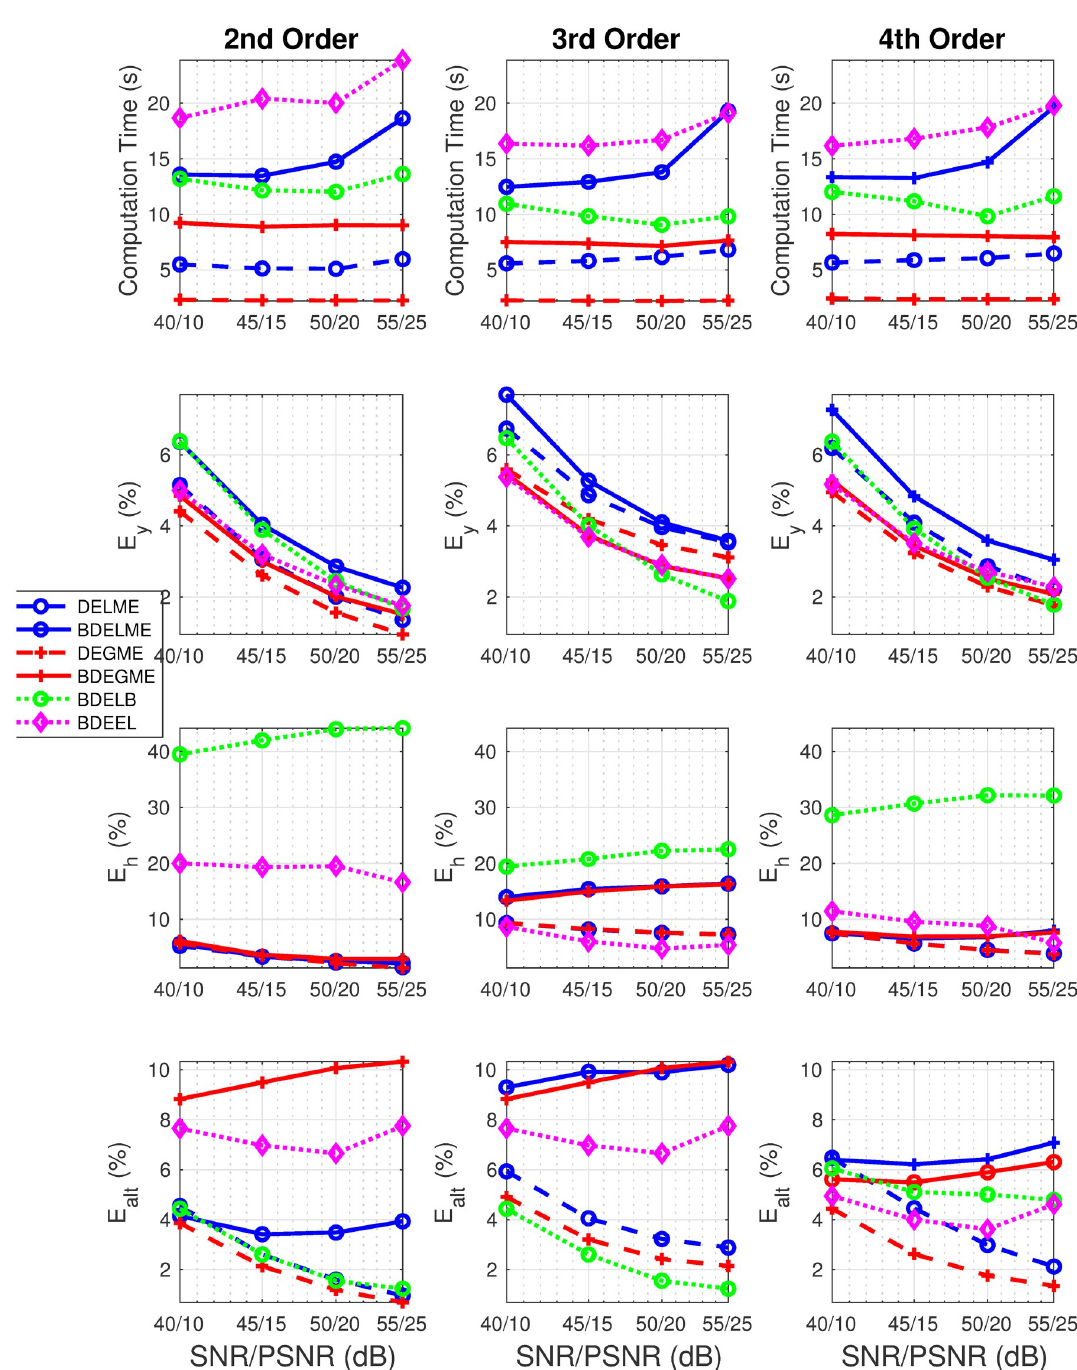
Fig 5. Performance metrics in synthetic evaluation with 2nd, 3rd and 4th order FluoIR models: (top row) Computational time, (middle-top row) E y , (middle-bottom row) E h , and (bottom row) E alt